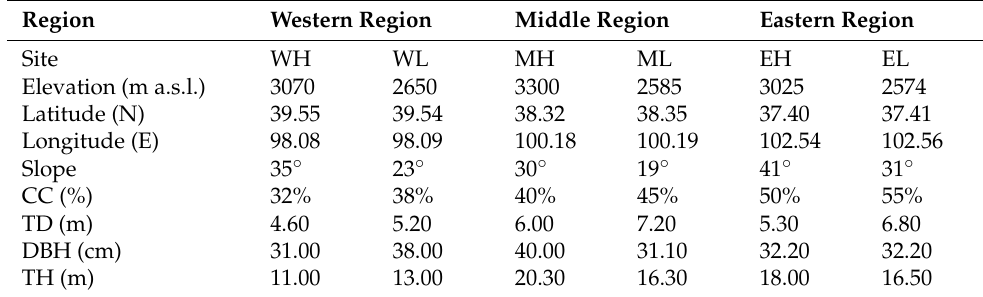
Table 1. Information about the sampling sites of Qinghai spruce.